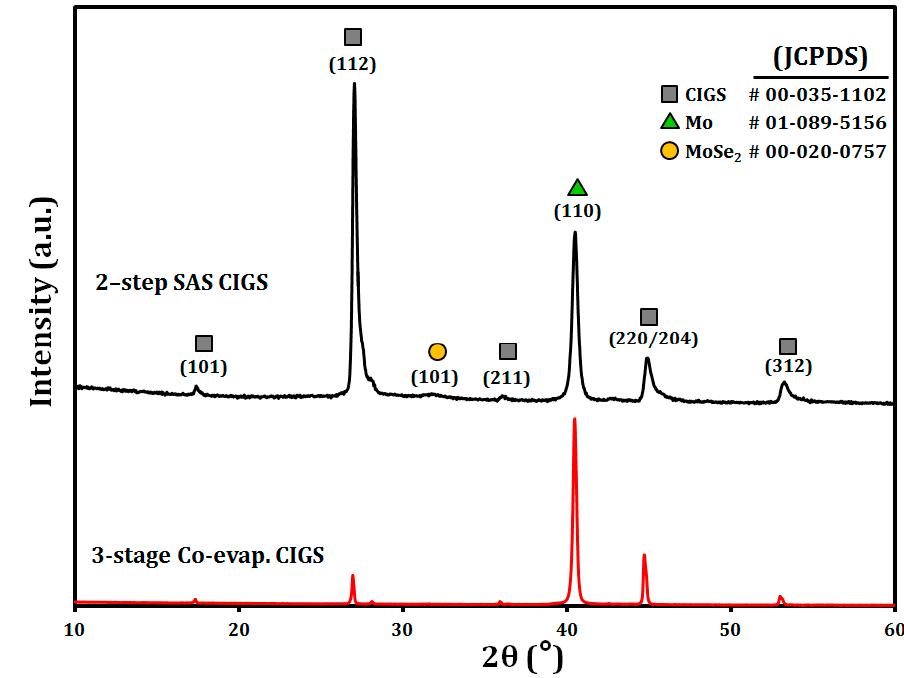
Figure 6. X-ray di ff raction patterns of the two-step SAS CIGS (top) and three-stage co-evaporated CIGS Figure 6. X-ray diffraction patterns of the two-step SAS CIGS (top) and three-stage co-evaporated films (bottom) grown on the glass / Mo CIGS films (bottom) grown on the glass/Mo substrates.